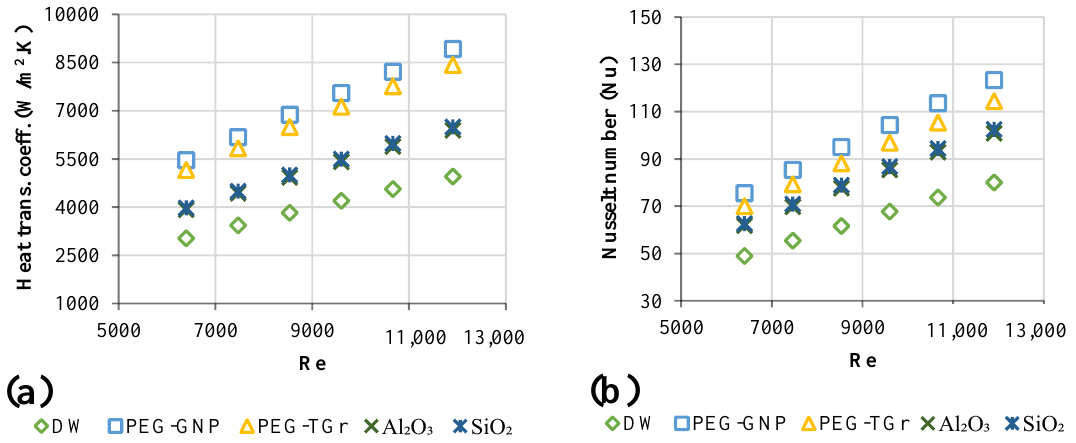
Figure 7. Heat transfer properties of different nanofluid types versus Reynolds numbers; ( a ) Heat transfer coefficients, ( b ) Average Nusselt number.